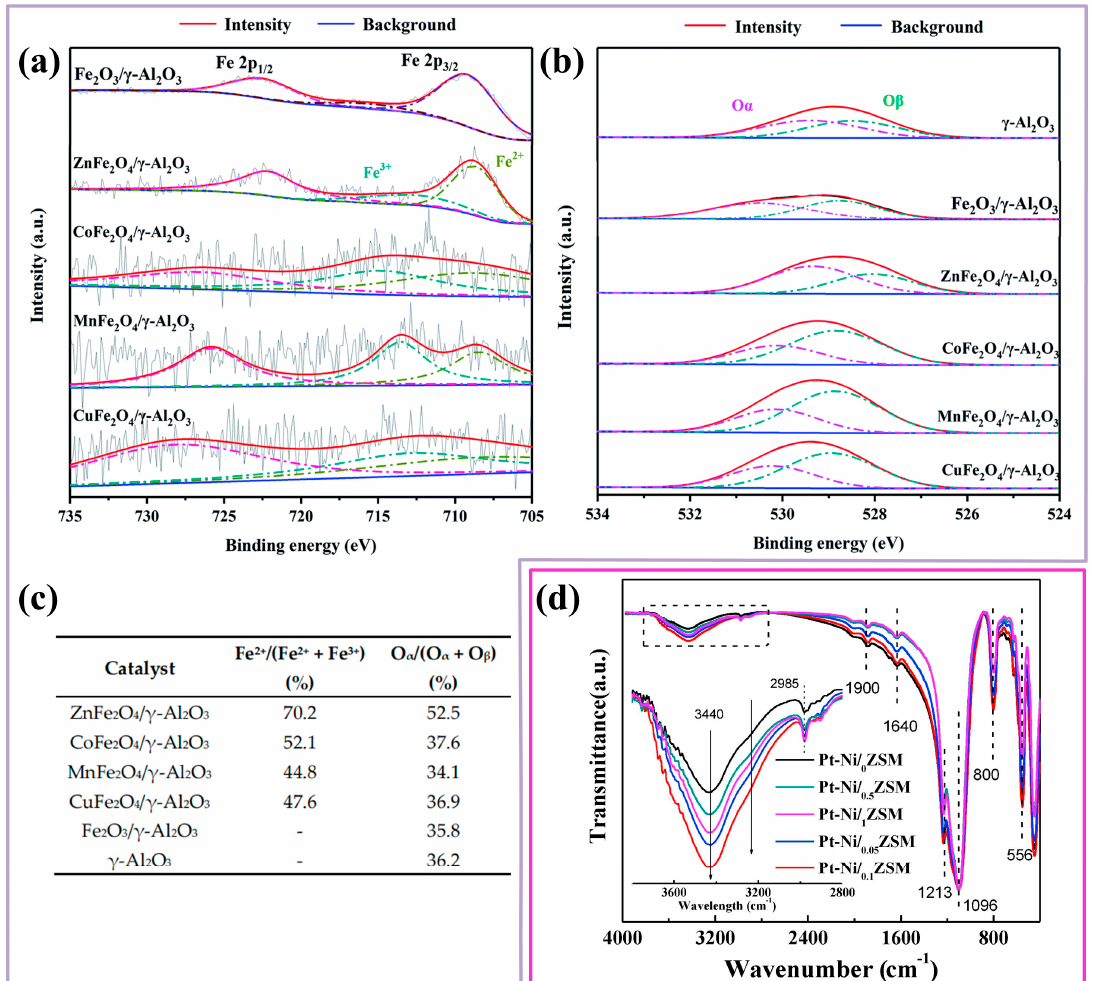
Figure 6. XPS spectra of ( a ) Fe 2p of Fe 2 O 3 / γ -Al 2 O 3 catalyst and AFe 2 O 4 / γ -Al 2 O 3 catalysts; ( b ) O 1s of γ -Al 2 O 3 , Fe 2 O 4 / γ -Al 2 O 3 catalyst and AFe 2 O 4 / γ -Al 2 O 3 catalysts; ( c ) XPS results of γ -Al 2 O 3 and AFe 2 O 4 / γ -Al 2 O 3 catalysts (O α : surface oxygen; O β : lattice oxygen). Reprinted with permission: Royal Society of Chemistry 2020 [44]; ( d ) FTIR spectra of Pt-Ni/ X ZSM (peak at ca. 3440 cm − 1 and ca. 1640 cm − 1 : the stretching and bending vibrations of OH; peak at ca. 2985 cm − 1 : terminal OH). Re- printed with permission: Elsevier 2018 [74].